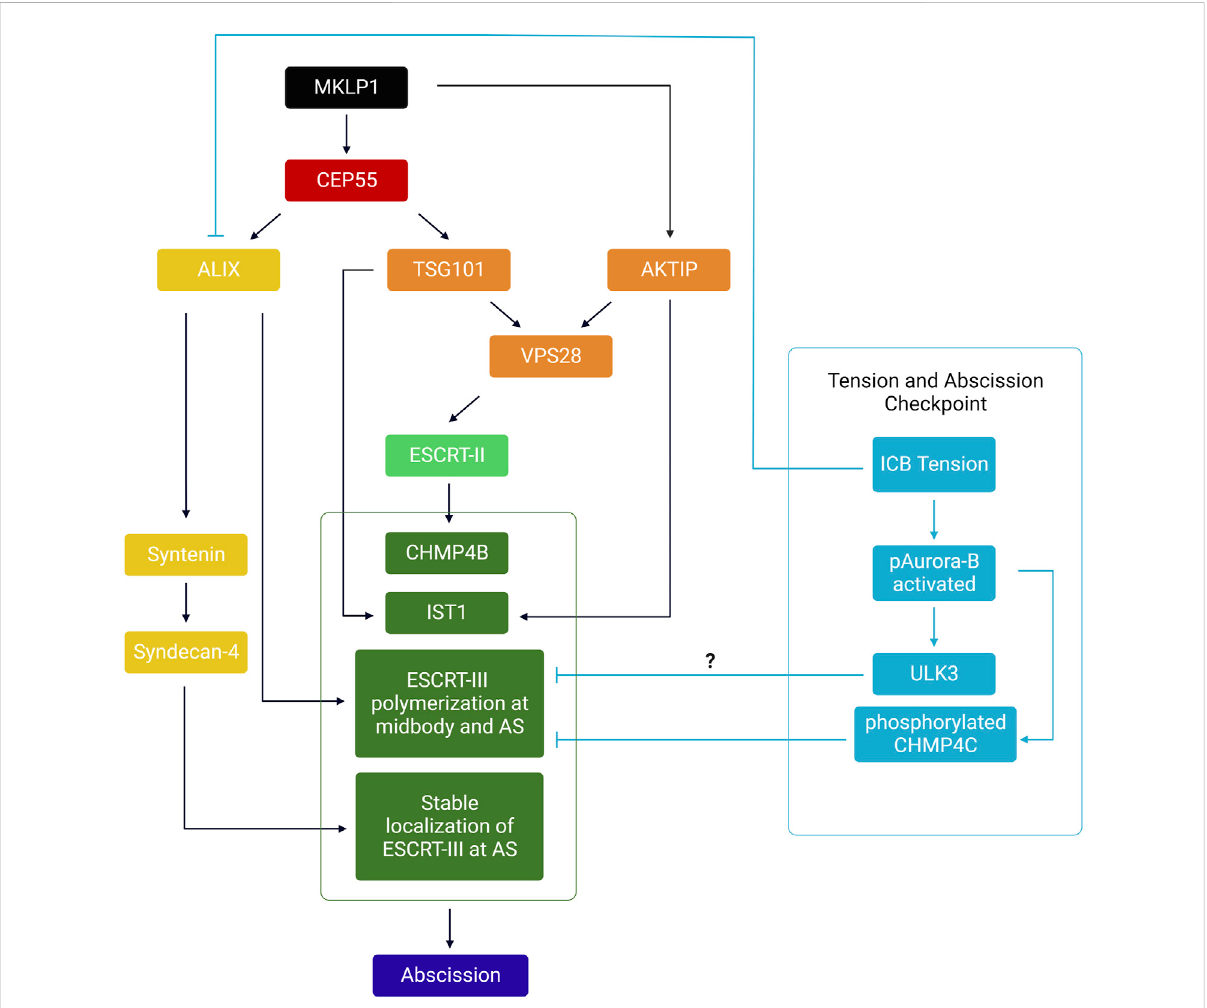
FIGURE 3 – Summary of the hierarchical events involved in the recruitment of the ESCRT-III machinery at the midbody and abscission site. MKLP1 at the